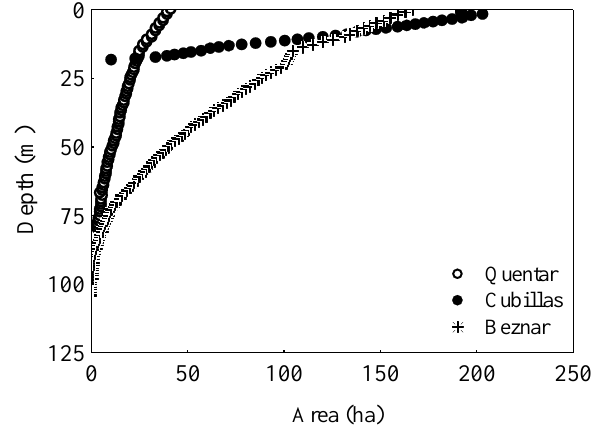
Fig. 1. Absolute hypsographic curves of area versus depth for the three study